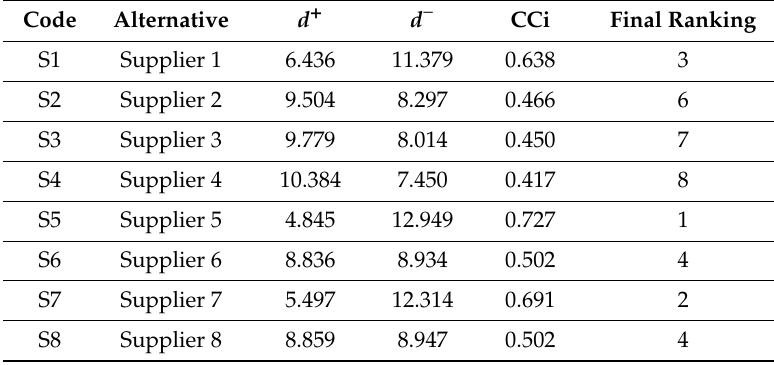
Table 8. The ranking of suppliers based on the closeness coe ffi cient CCi